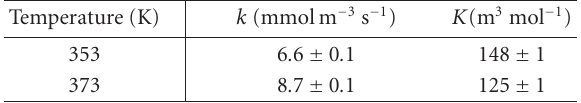
Figure 6: Reciprocal PCO reaction rates on TiO 2 versus the recip- rocal MA initial concentrations at ( (cid:2) ) 353 and ( (cid:2) ) 373 K. Table 1: Reaction rate constants and Langmuir adsorption coe ffi - cients for PCO of